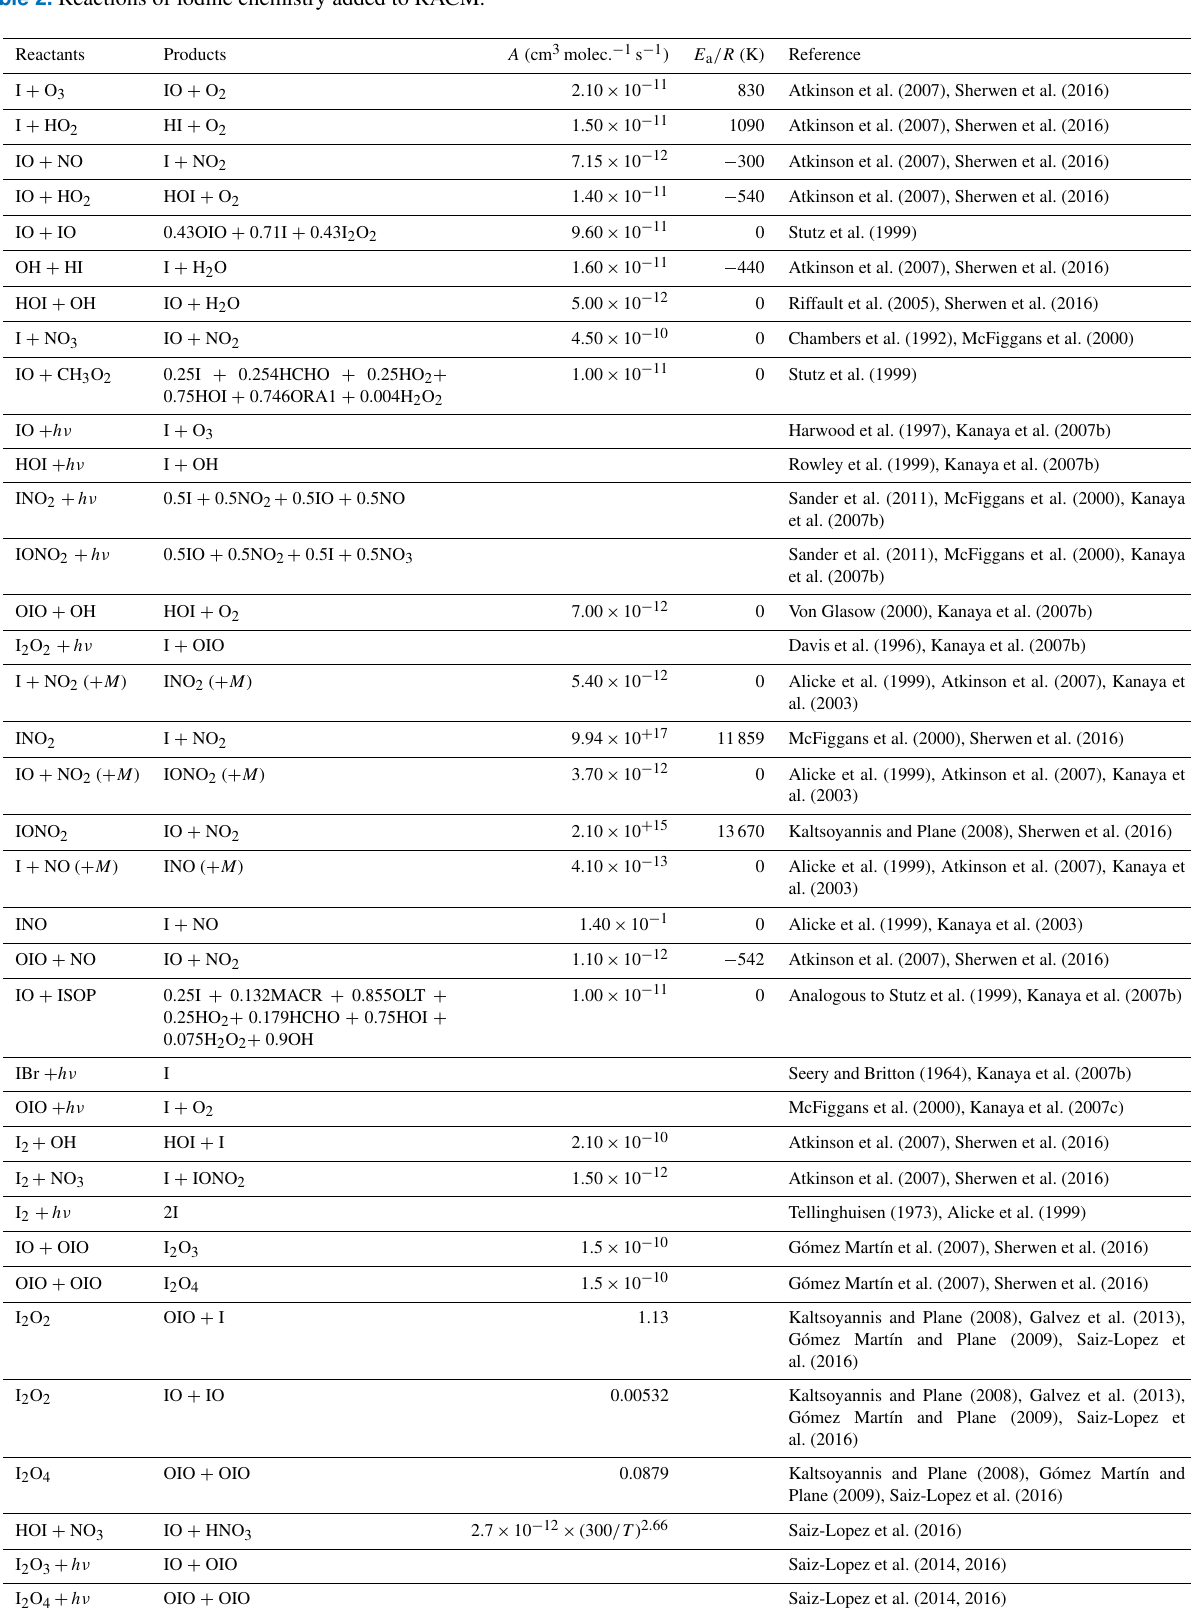
Table 2. Reactions of iodine chemistry added to